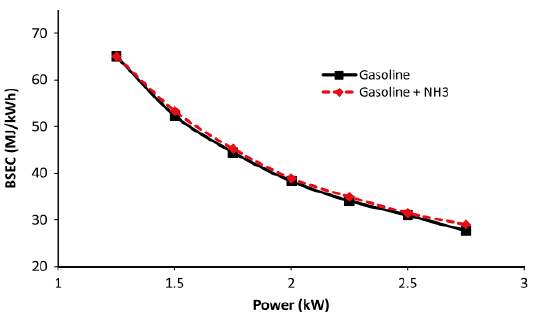
Figure 5. Effect of ammonia injection delay on engine power.